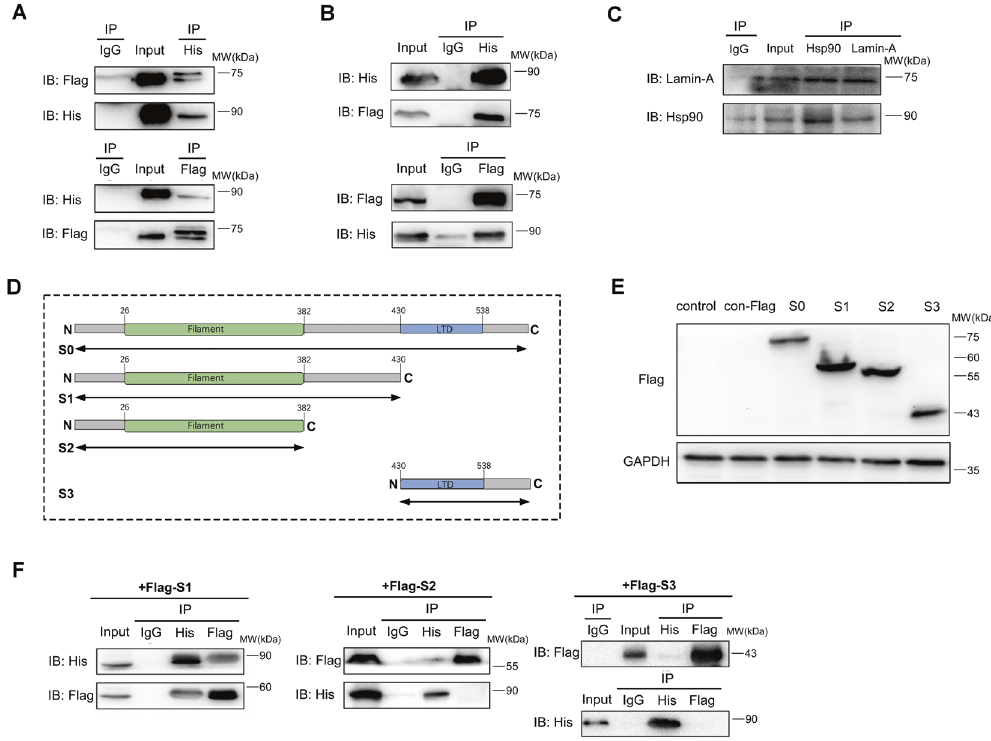
Fig. 2 Lamin-A can interact with Hsp90 via the domain of lamin-A 1-430 . A and B Flag-tagged lamin-A ( fl ag-lamin-A) and his-tagged Hsp90 (his-Hsp90) were co-expressed in cells for co-IP analysis using anti fl ag or antihis antibodies (A: HO-8910 cells, B: 293 T cells). Flag-lamin-A and his-Hsp90 were detected with their speci fi c antibodies, respectively. Co-IP with IgG serves as a negative control. C Lamin-A and Hsp90 could interact in HO-8910 cells without transfecting the exogenous tagged plasmid. D Domains of lamin-A and its different derivatives (S0 – S3) constructed. E The expression of truncations in 293 T cells, with GAPDH as the internal reference. F His-Hsp90 and truncations of lamin-A (S1 – S3) were co-expressed in 293 T cells for co-IP analysis using anti fl ag or antihis antibodies. Flag-lamin-A and his-Hsp90 were detected with their speci fi c antibodies, respectively. Co-IP with IgG serves as a negative